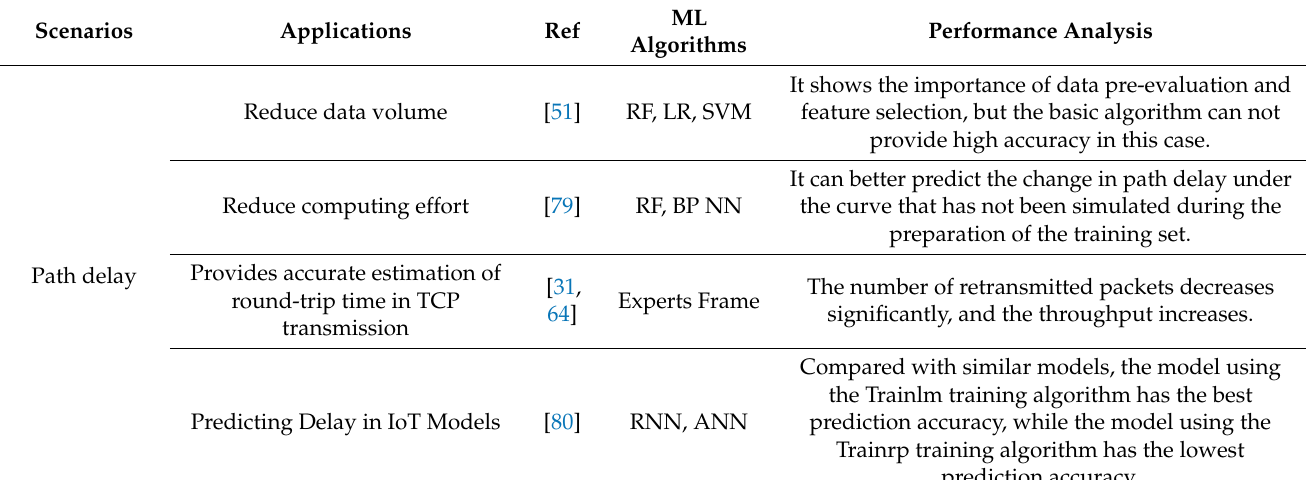
Table 3. Network Measurement Application and ML Algorithm Performance